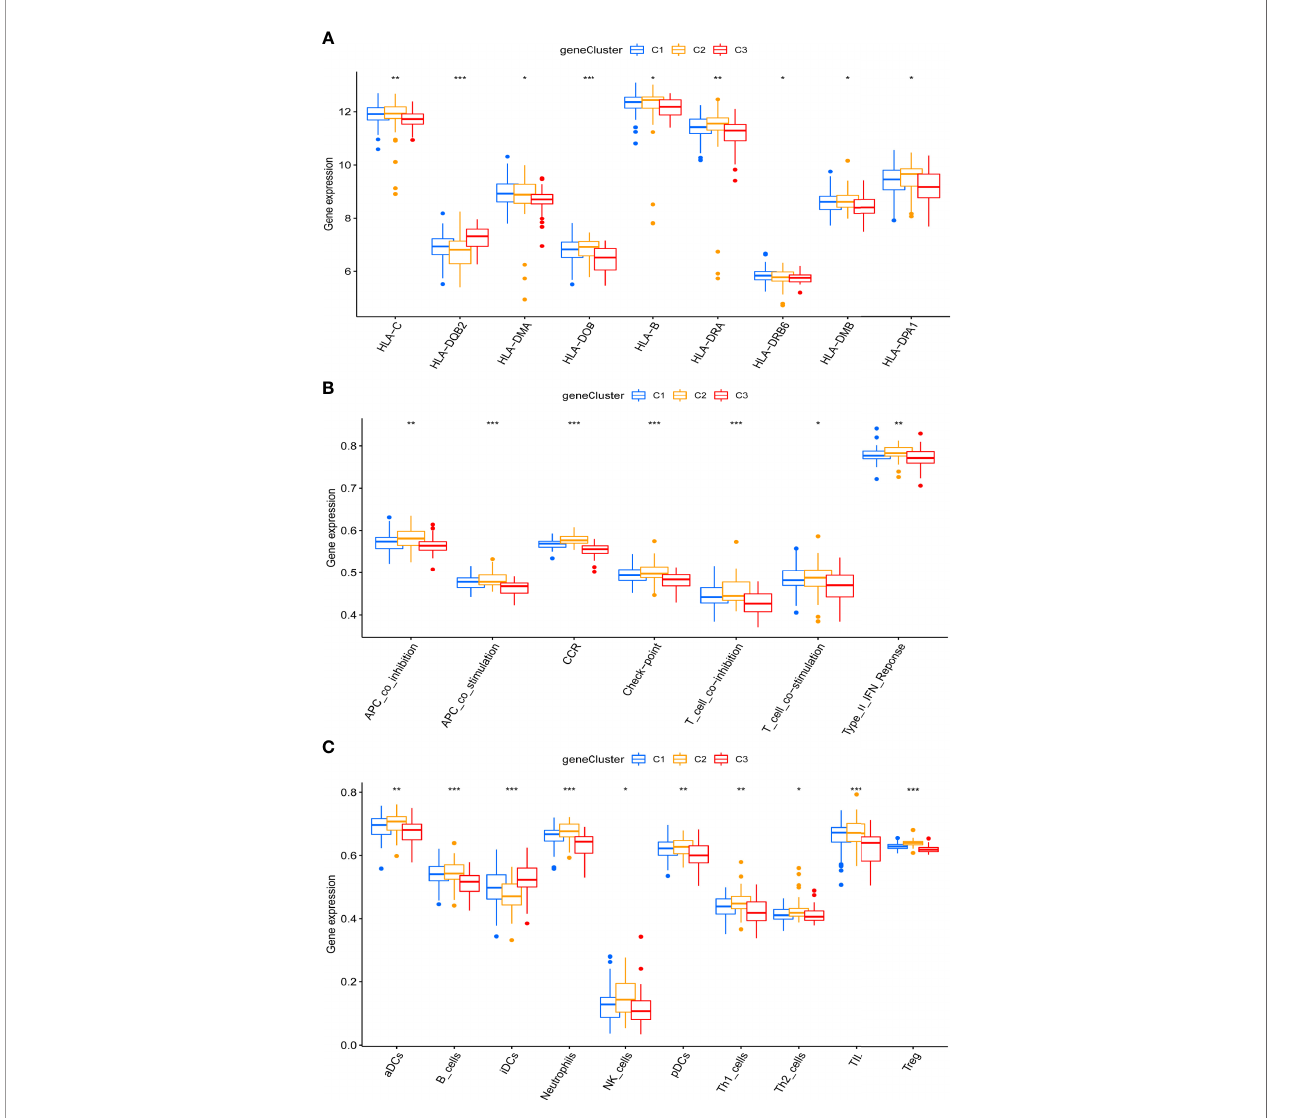
FIGURE 6 | Distinct immune characteristics underlined in the three pyroptosis-related clusters. (A – C) Human leukocyte antigen (HLA) gene expression (A) , immune pathway activities (B) , and immune cell in fi ltration (C) of the three pyroptosis-related clusters. * P < 0.05, ** P < 0.01, *** P <